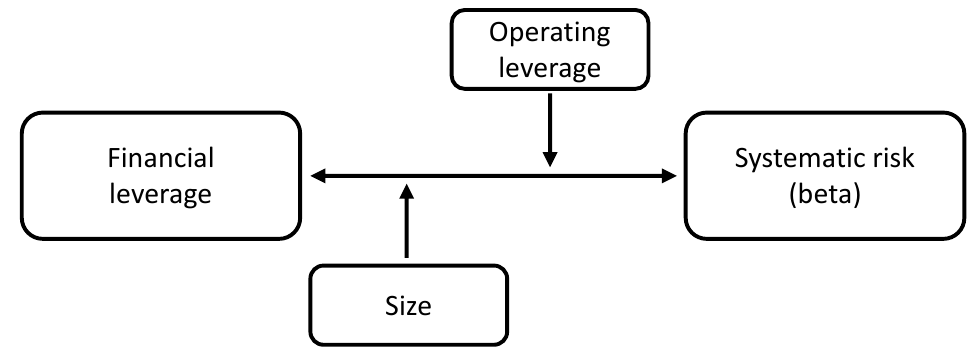
Figure 2. The conceptual framework for hypothesis